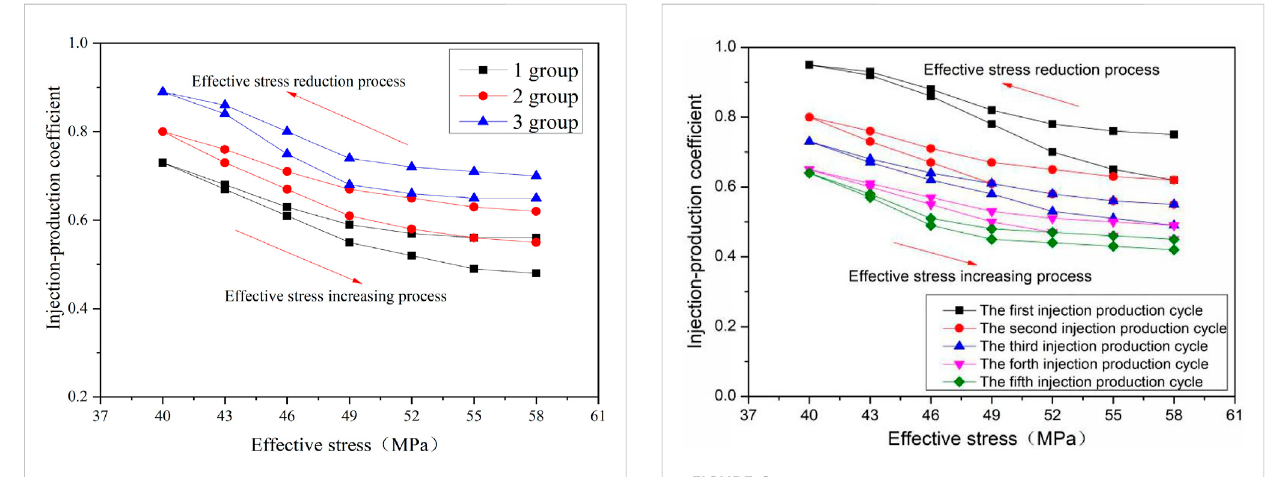
FIGURE 5 Injection-production coef fi cient of internal characteristic value of different reservoirs changes with effective stress.